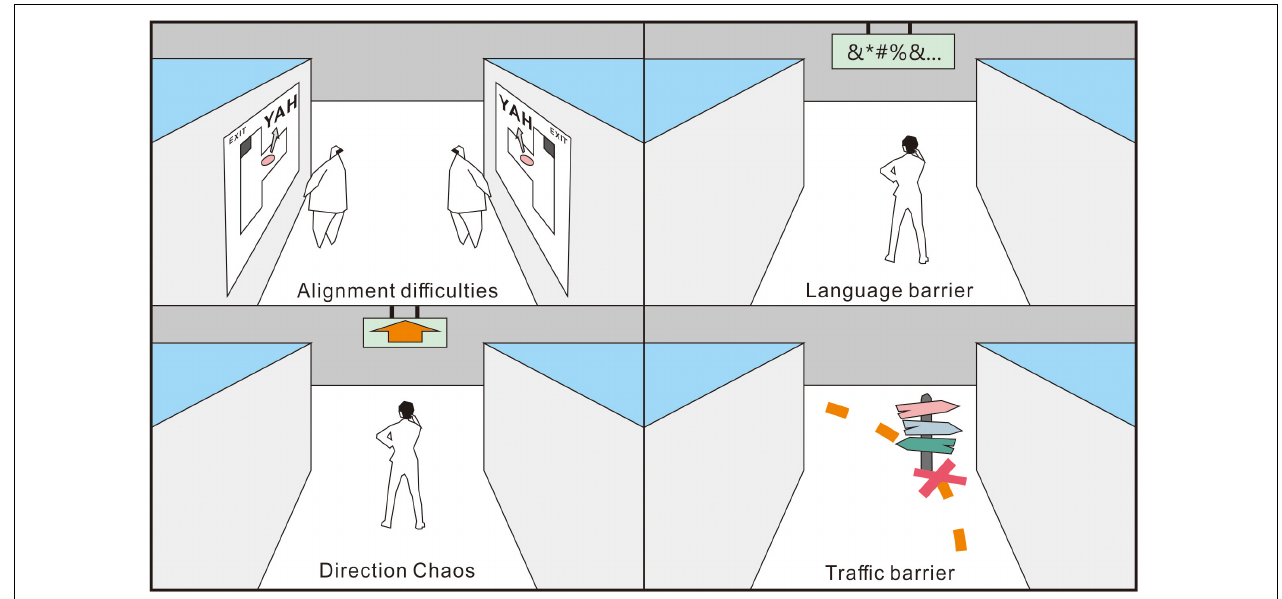
FIGURE 1 | Potential issues with the use of signage strategies during wayfinding (cf., Levinew et al.,